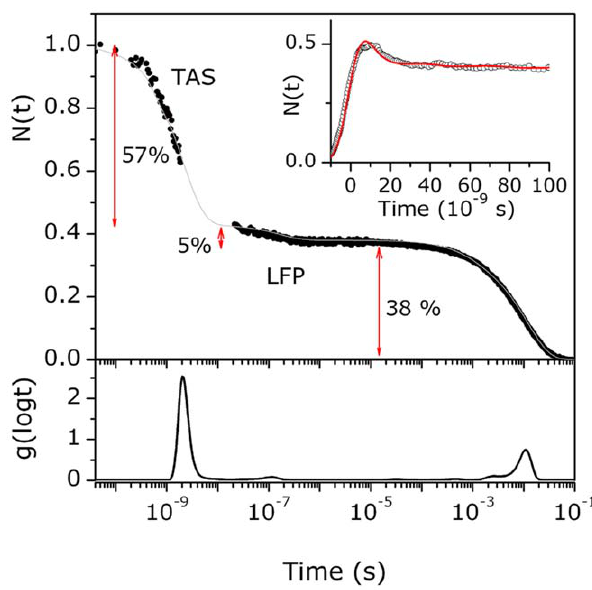
Figure 4. Complete rebinding kinetics. Top : Merging rebinding curves measured in TA and LFP experiments: fraction of the 5c-protein - N(t)= D A(t)/ D A(t 0 ) - as a function of the delay time after excitation. In the inset the experimental profile recorded at early delay times after photolysis with ns laser pulses (open circles) is reported in comparison with the convolution result (red solid line). The kinetic trace in the first 20 ns is affected by the instrumental function. Bottom : Lifetime distributions associated with the rebinding kinetics in the top panel.